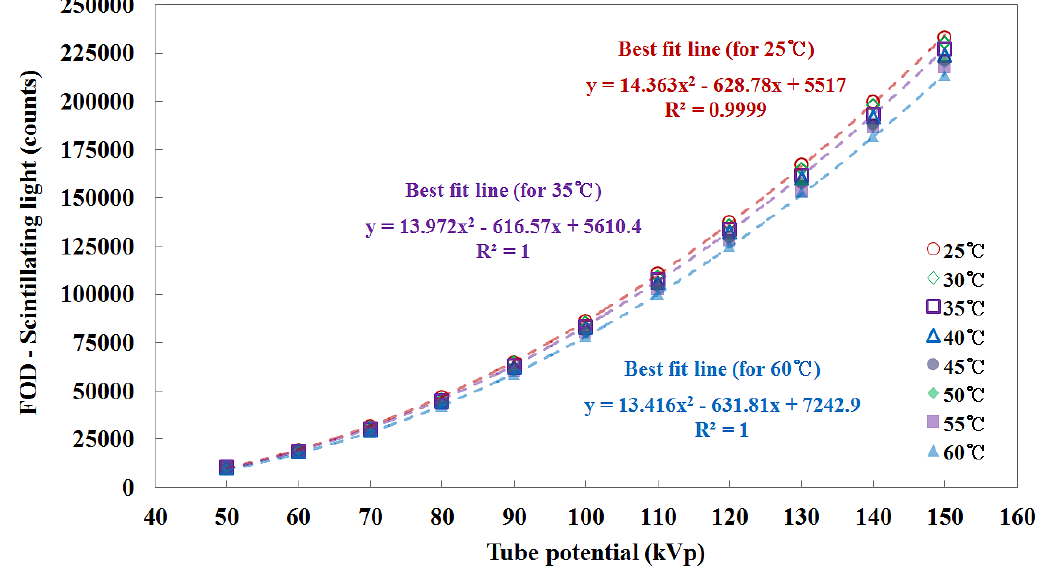
Figure 5. Total counts of the scintillating light signals measured by the FOD according to the tube potential under changing temperature of